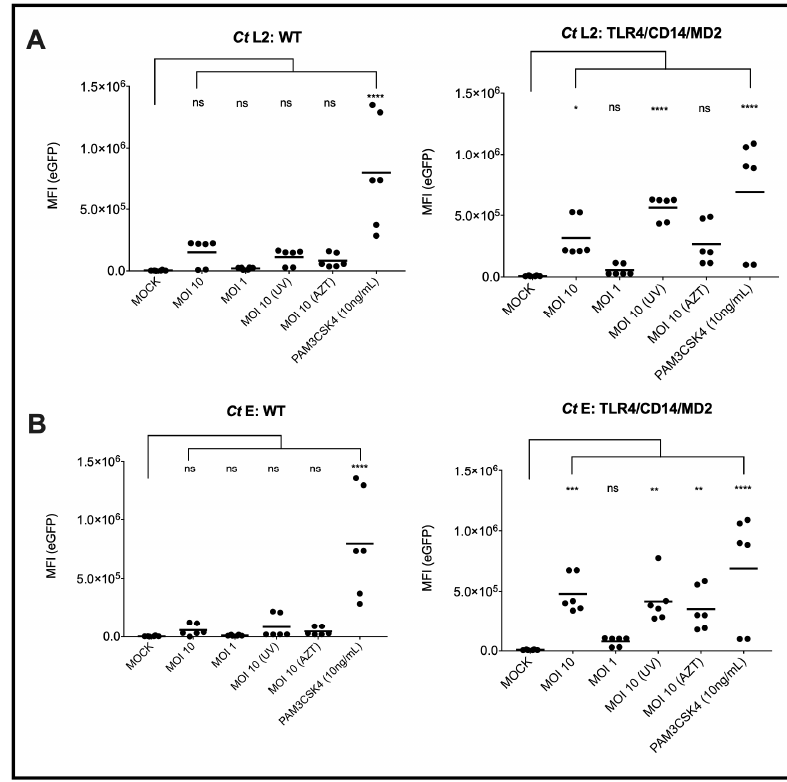
Figure 1. NF- κ B induced expression of eGFP by Ct in WT or TLR4/CD14/MD2 THP-1 reporter cells. The eGFP-MFI of three independent experiments was measured 20 h post inoculation of the cells with Ct serovar L2 ( A ) or E ( B ). PAM3CSK4 was used as control for a TLR4/CD14/MD2 independent activation of the reporter cells by naturally expressed TLR1/2. Statistical differences between mock and different conditions were assessed by 2way ANOVA followed by Dunnett’s multiple comparisons test. * p < 0.05, ** p < 0.01, *** p < 0.001, **** p < 0.0001; ns, not significant. Individual measurements are shown (n = 6), each experiment was performed in